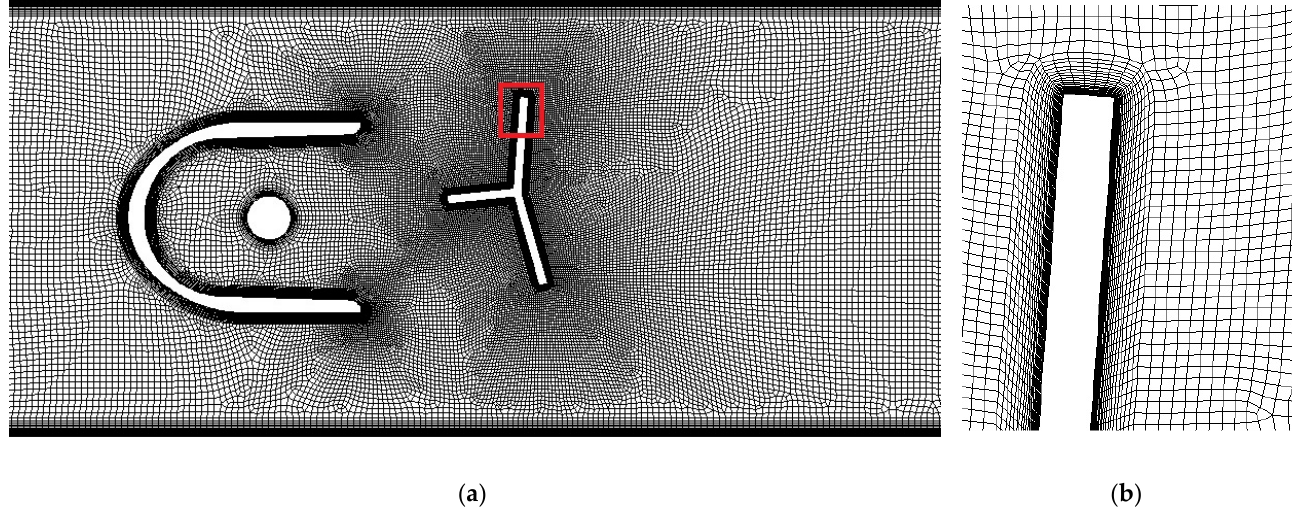
Figure 9. Two-dimensional mesh: ( a ) proximity of the oscillator, zoomed area marked in red; ( b ) boundary layers on the oscillator’s surface.